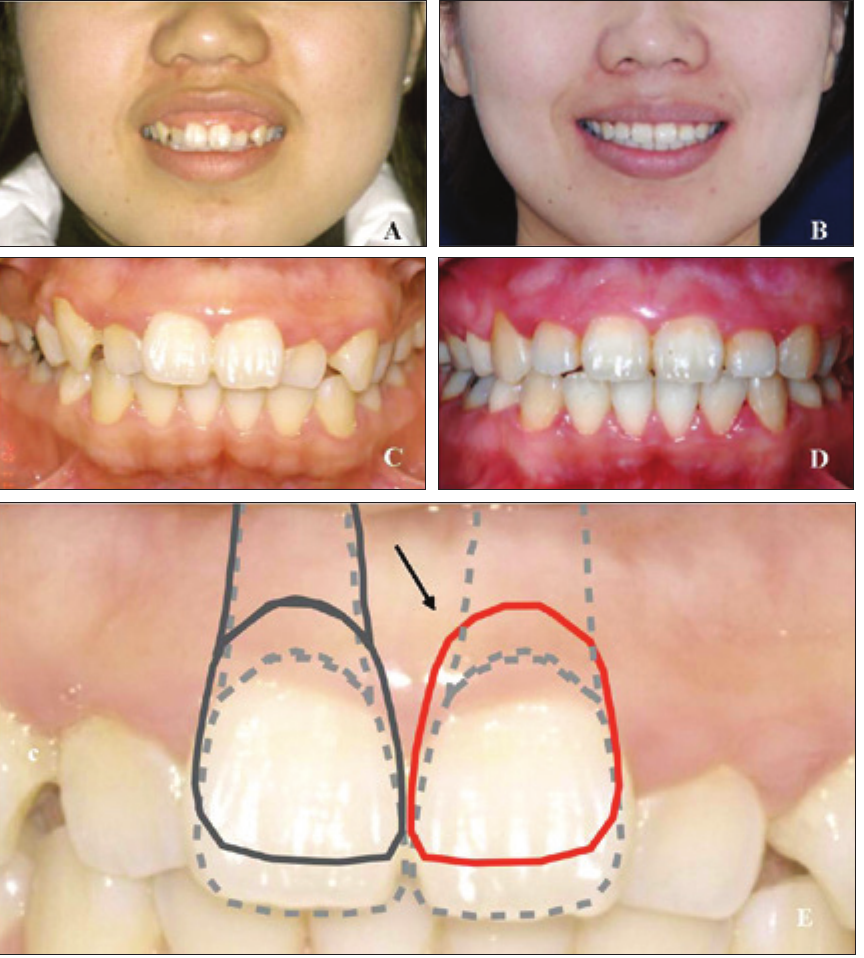
Figure 4. (A, C) The patient complained of a gummy smile, and the incisal edges of the anterior teeth were positioned more coronally. Incisal line is the second parameter of an intraoral smile analysis. An ideal incisal line should be in harmony with the lower lip. Inharmonious incisal lines and excessive tooth display at rest suggest the necessity of orthodontic treatment. (B, D) The patient underwent orthodontic treatment, including intrusion of the upper teeth and retraction of the upper and lower dentition. She had a harmonious smile after orthodontic treatment. (E) In such a case, orthodontic treatment to intrude the teeth is better than incisal edge reduction in combination with surgical crown lengthening to restore the normal length of the anterior teeth. One reason is that orthodontic treatment can preserve tooth structure. Secondly, the intruded anterior teeth maintain their normal emergence profile, whereas surgical crown lengthening may expose the root portion, leading to narrower mesiodistal dimensions and most likely resulting in overhanging